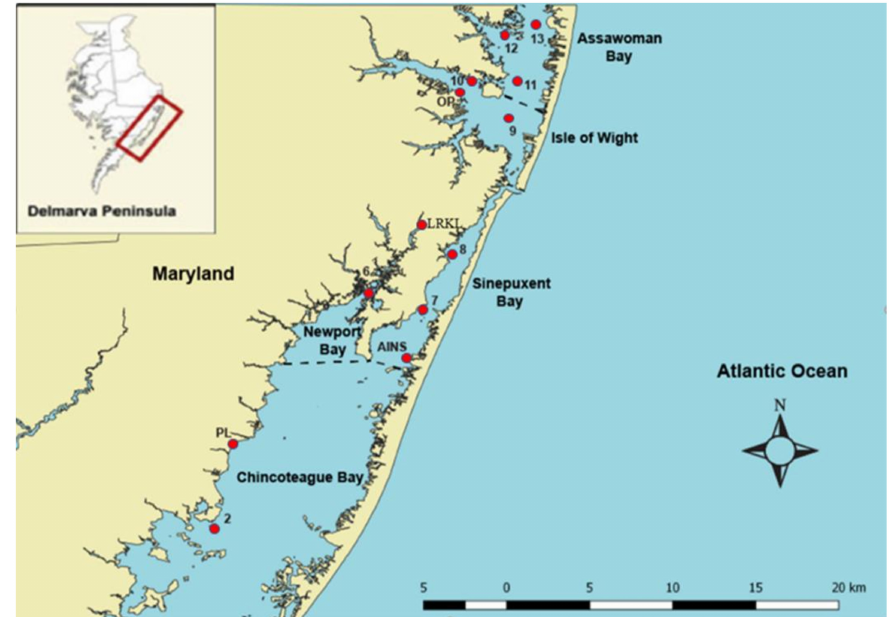
Figure 1. Map of the Maryland Coastal Bays showing the sampling